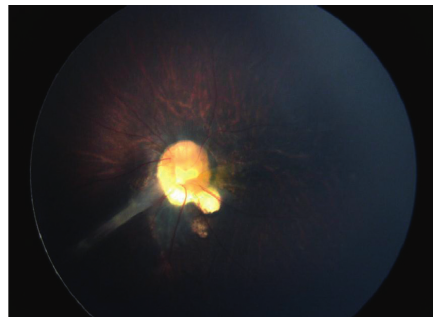
Figure 3: Fundus photography of the left eye. The photo shows attenuated vessels and a fibrovascular stalk extending from the optic disc which was large and dysplastic.